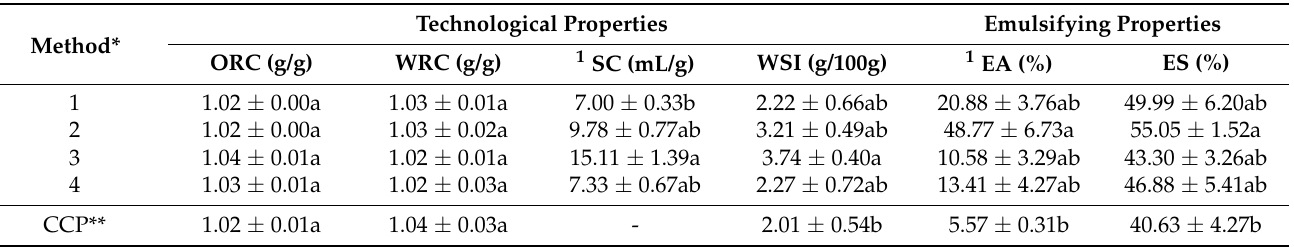
Table 3. Technological properties of the pectins obtained from jabuticaba peel using different extrac- tion